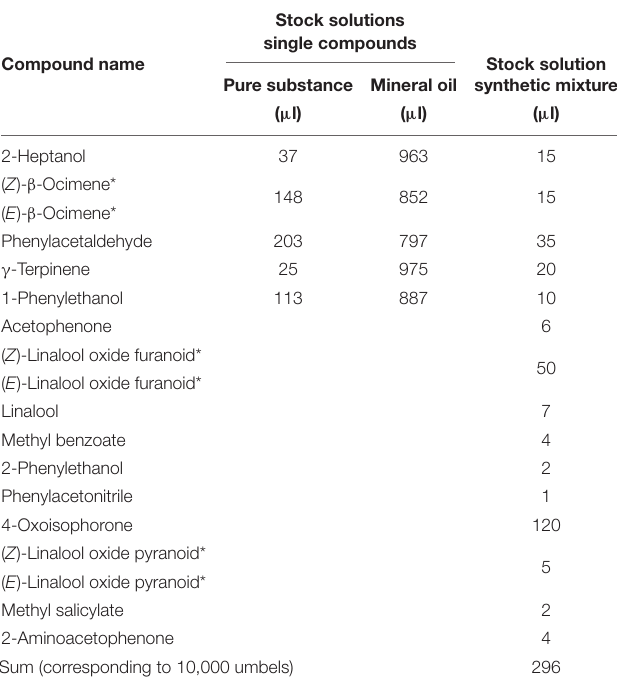
TABLE 2 | Composition of synthetic solution from Hedera helix based on semi-quantitative amounts identified in headspace samples according to Table 1 . Stock solutions single